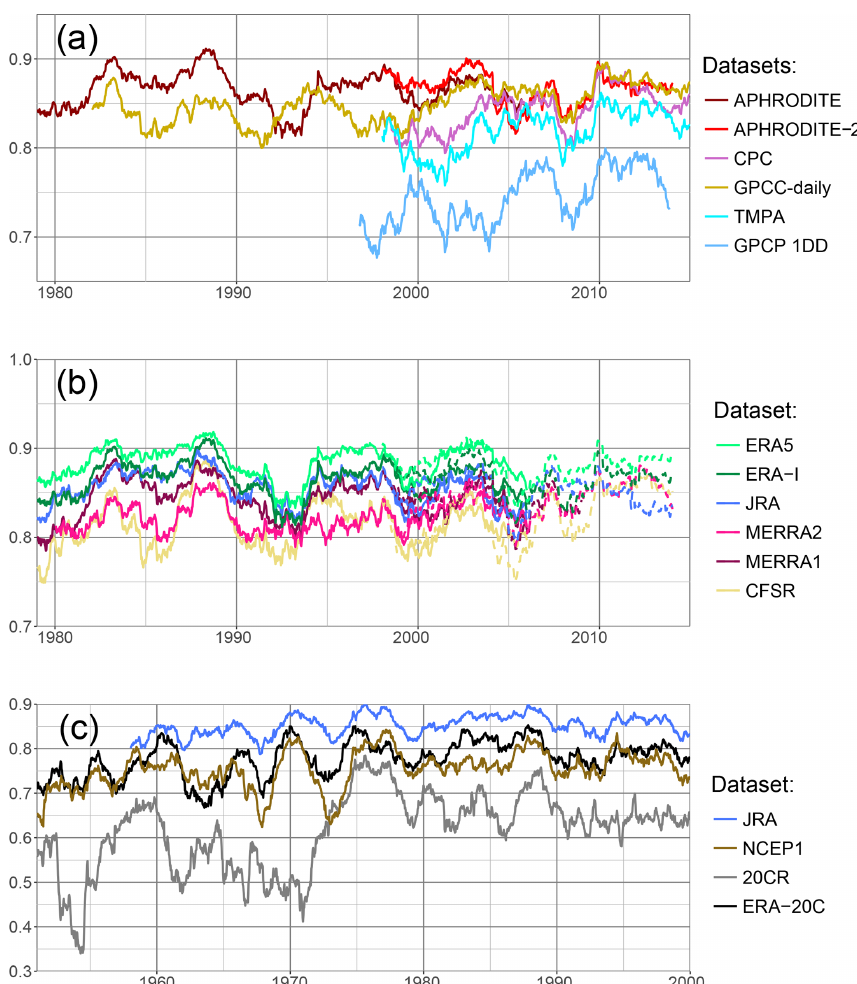
Figure 7. Same as Fig. 6 but for the lower